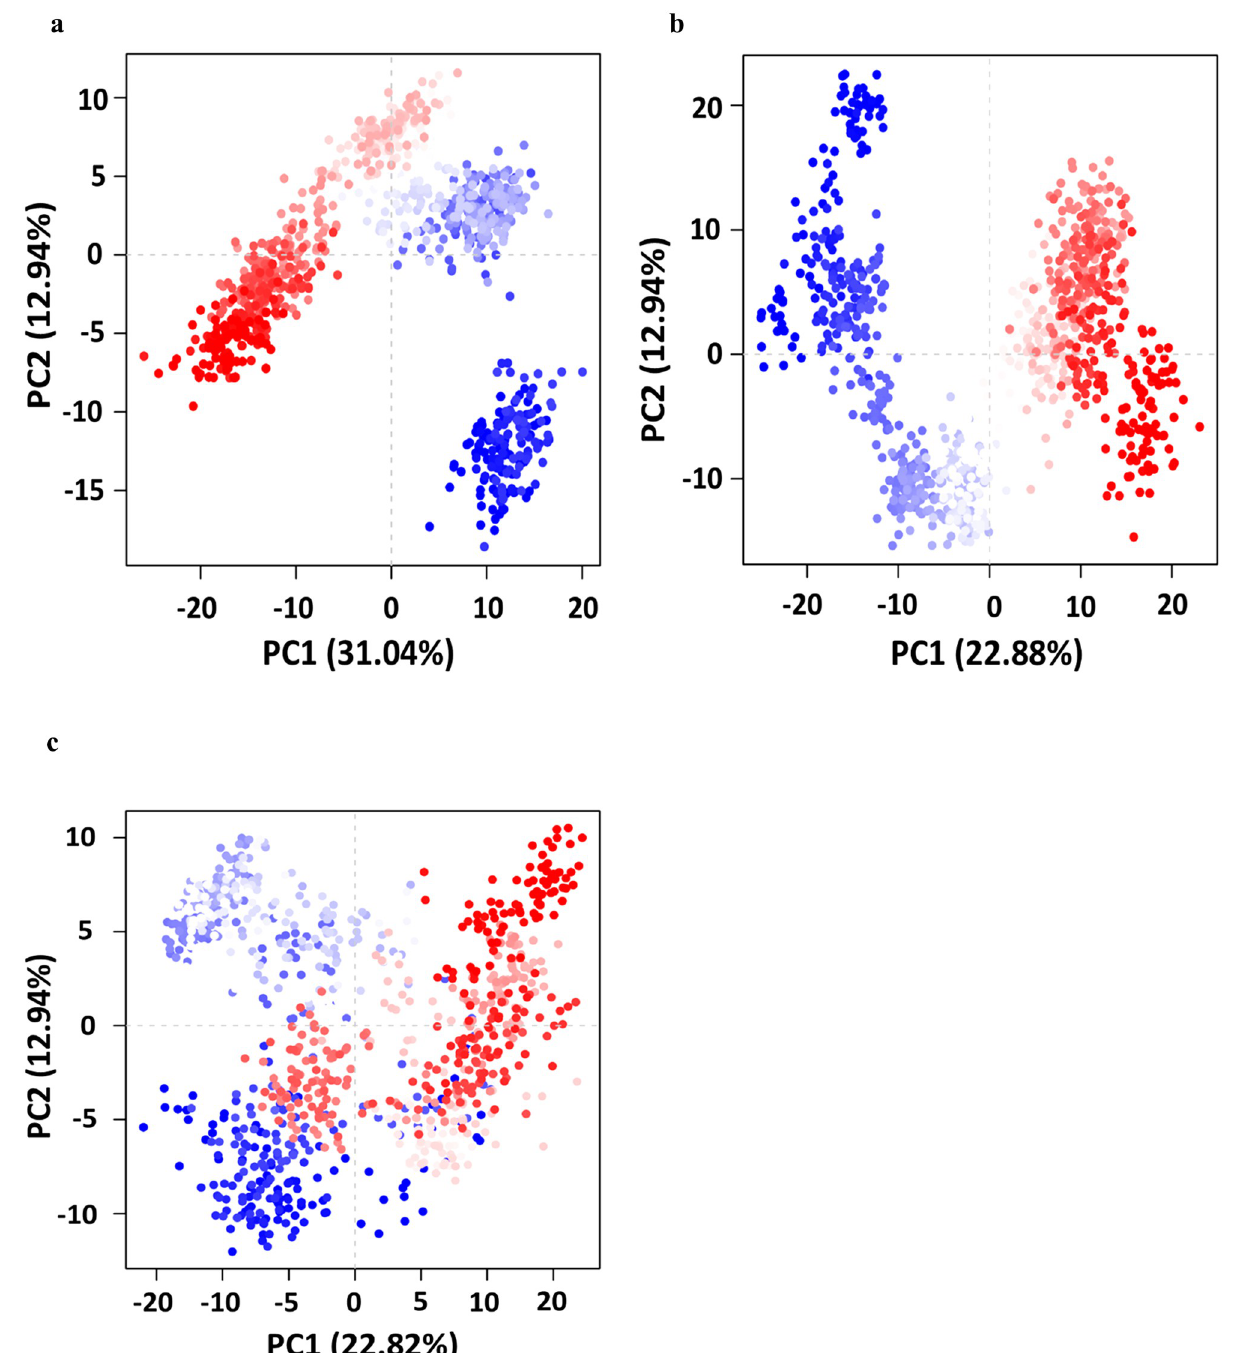
Fig 7. Principal component analysis (PCA) plots for HDAC2 conformations in apo, pitolisant-bound and SAHA-bound trajectory frames (coloured from blue to red in order of time). PC1 and PC2 collectively account for first 2 eigenvalue ranks with overall variations of 43.98% (Apo), 35.82% (Pitolisant) and 35.76% (SAHA) in HDAC2 structure.